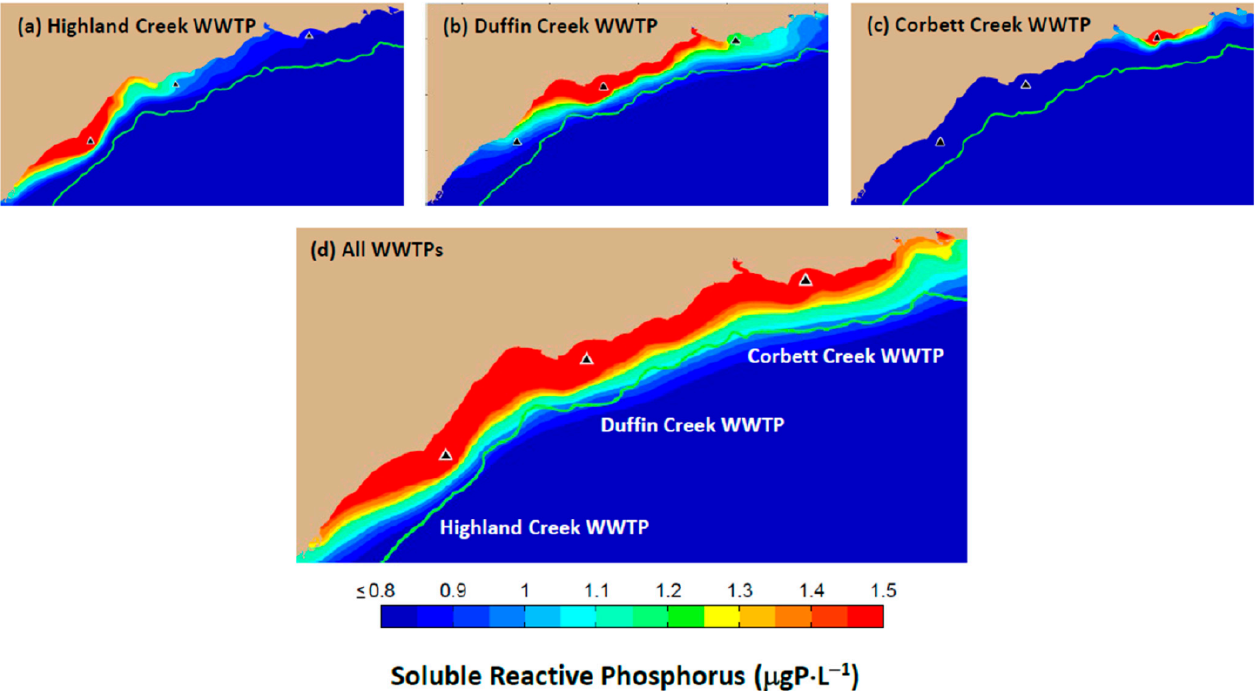
Figure 12. Simulations of the bottom water SRP footprint for ( a ) the Highland Creek WWTP, ( b ) the Duffin Creek WWTP and ( c ) the Corbett Creek WWTP as sole-source discharges with contemporary treatment levels and flows and ( d ) the resulting multiple source discharge. The green line represents the maximum lakeward extent of Cladophora colonization (to the 20 m